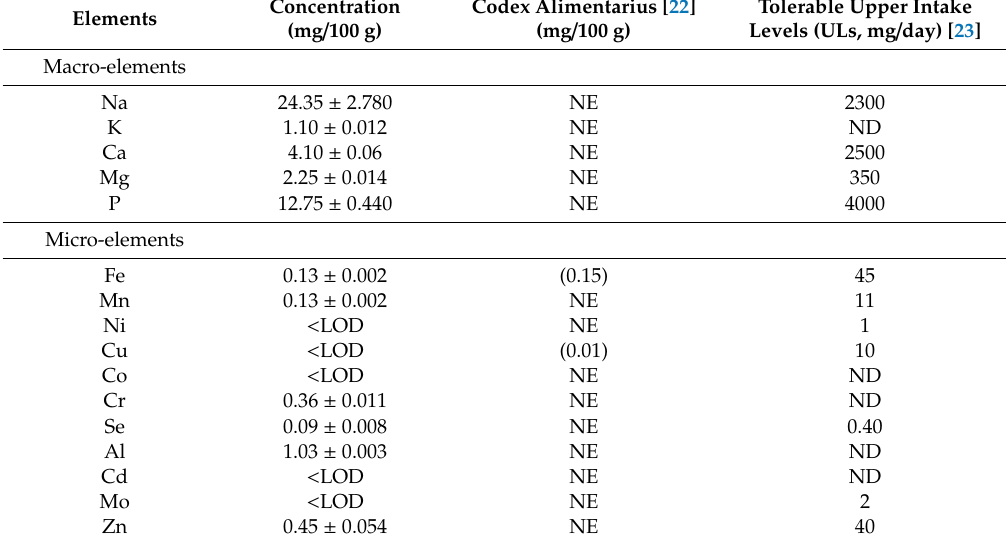
Table 4. Elemental concentration of macro and microelements in the oil of the babassu ( A. speciosa ) compared with values of the Codex Alimentarius for refined oils and Tolerable Upper Intake levels for adults (31–50 y). Concentration Codex Alimentarius [22] Tolerable Upper Intake Elements (mg / 100 g) (mg / 100 g) Levels (ULs, mg / day)